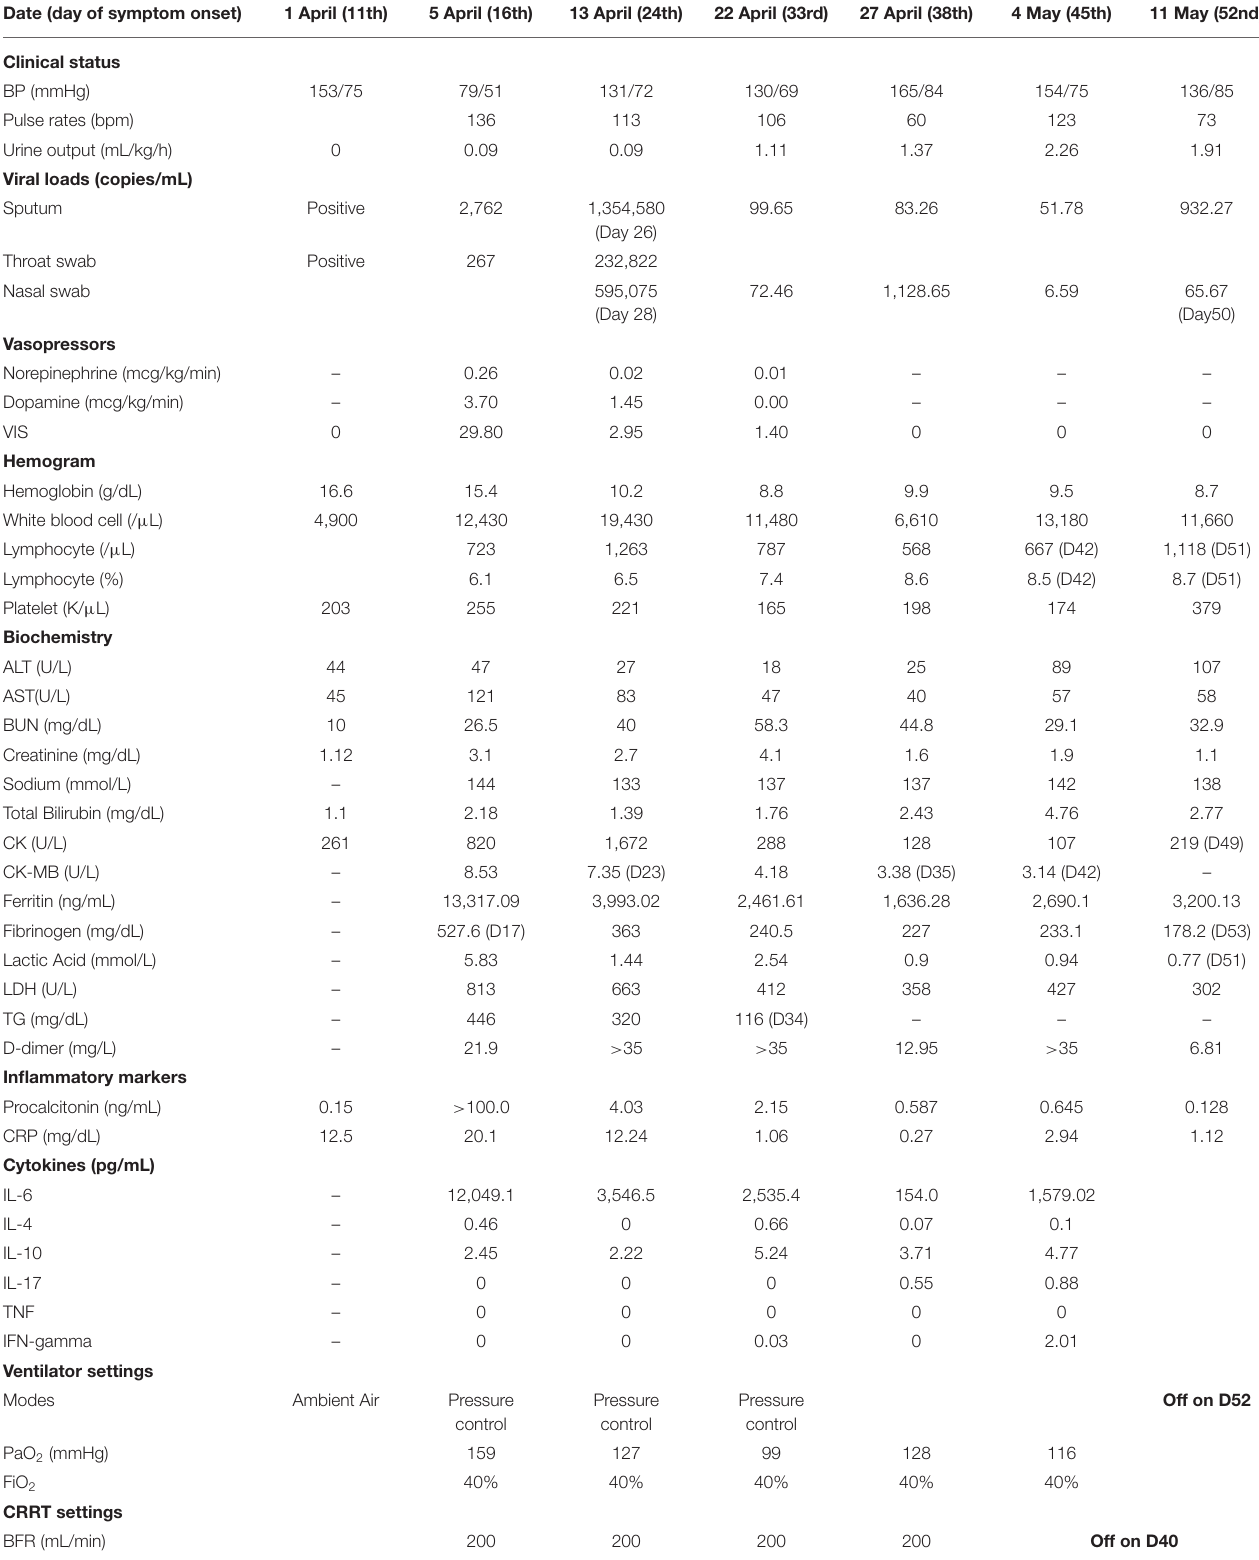
TABLE 1 | Baseline characteristics, treatment courses, and relevant data of the reported